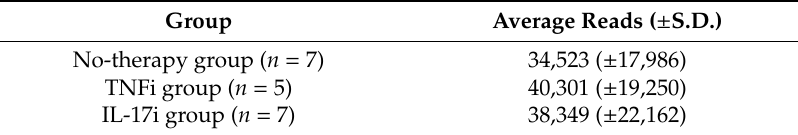
Table 2. The average number of reads per group.